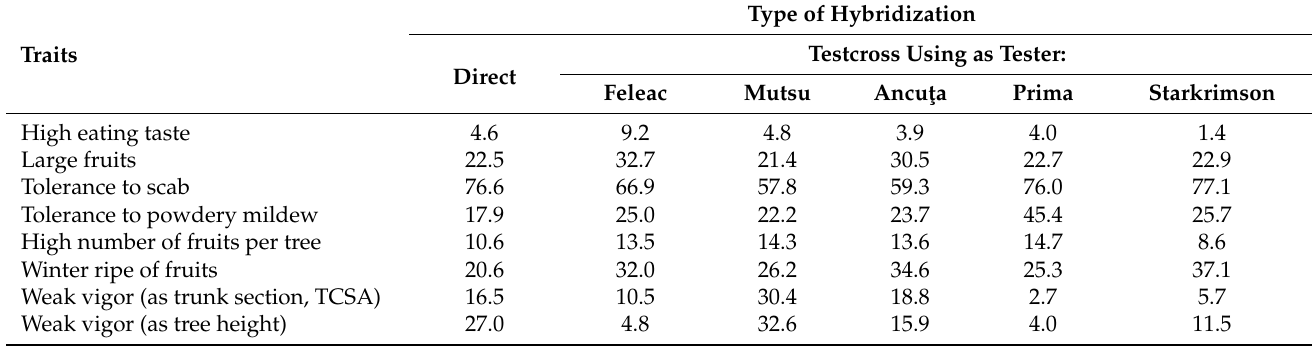
Table 10. The percentage of F 1 apple hybrids that showed the analyzed traits expressed at an optimal level for